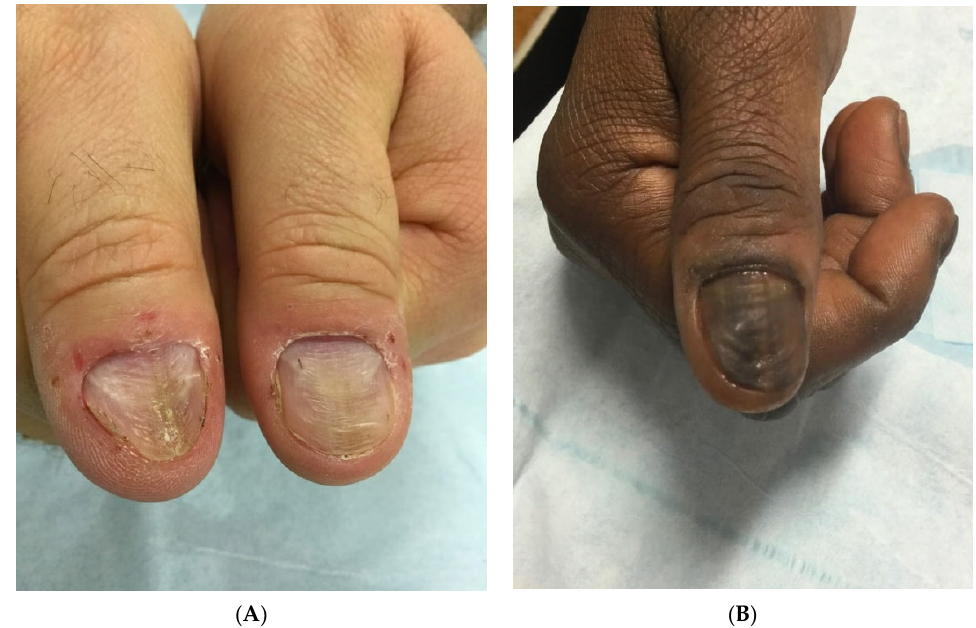
Figure 3. ( A ) A 58-year-old nail picker with habit tic deformity of the bilateral thumbnails. There are parallel transverse grooves in the nail plate. ( B ) A 54-year-old nail picker with transverse grooves in the nail plate (habit tic deformity) and longitudinal melanonychia from chronic nail